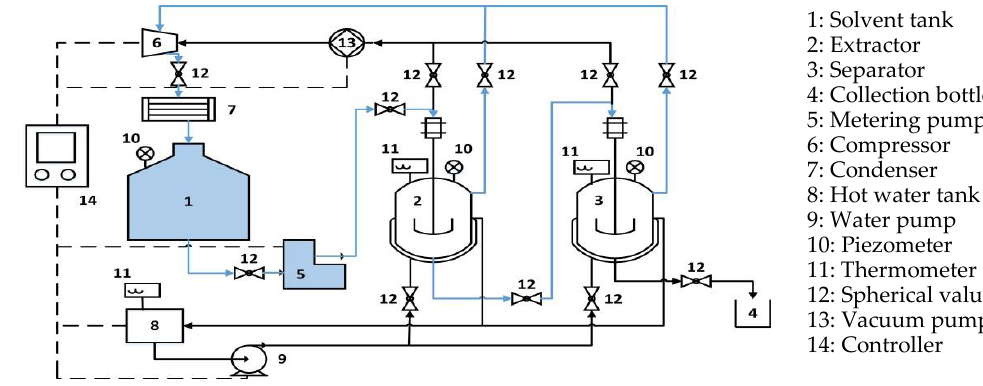
Figure 4. Schematic diagram of the SBE process.